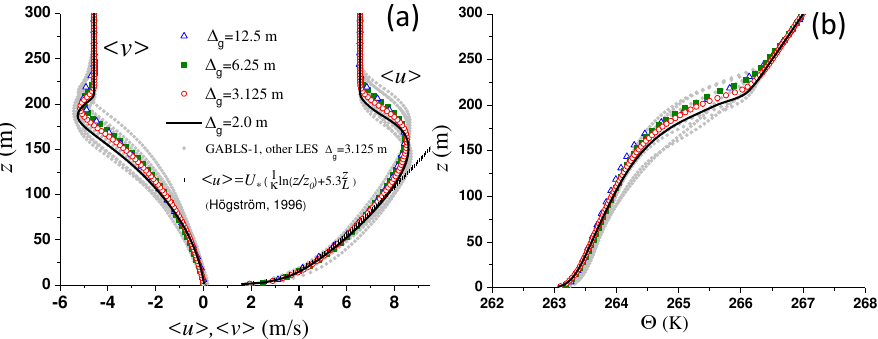
Figure 2. Mean wind velocity (cid:104) u (cid:105) (a) and temperature (cid:104) (cid:50) (cid:105) (b) in runs with different grid steps (spatial step is pointed in legend). Gray dots are the data from other LES models obtained in Beare et al. (2006) (wind velocity is rotated 35 ◦ clockwise). “Standard” wind profile for stable conditions in accordance with Högström (1996) is shown by the vertical